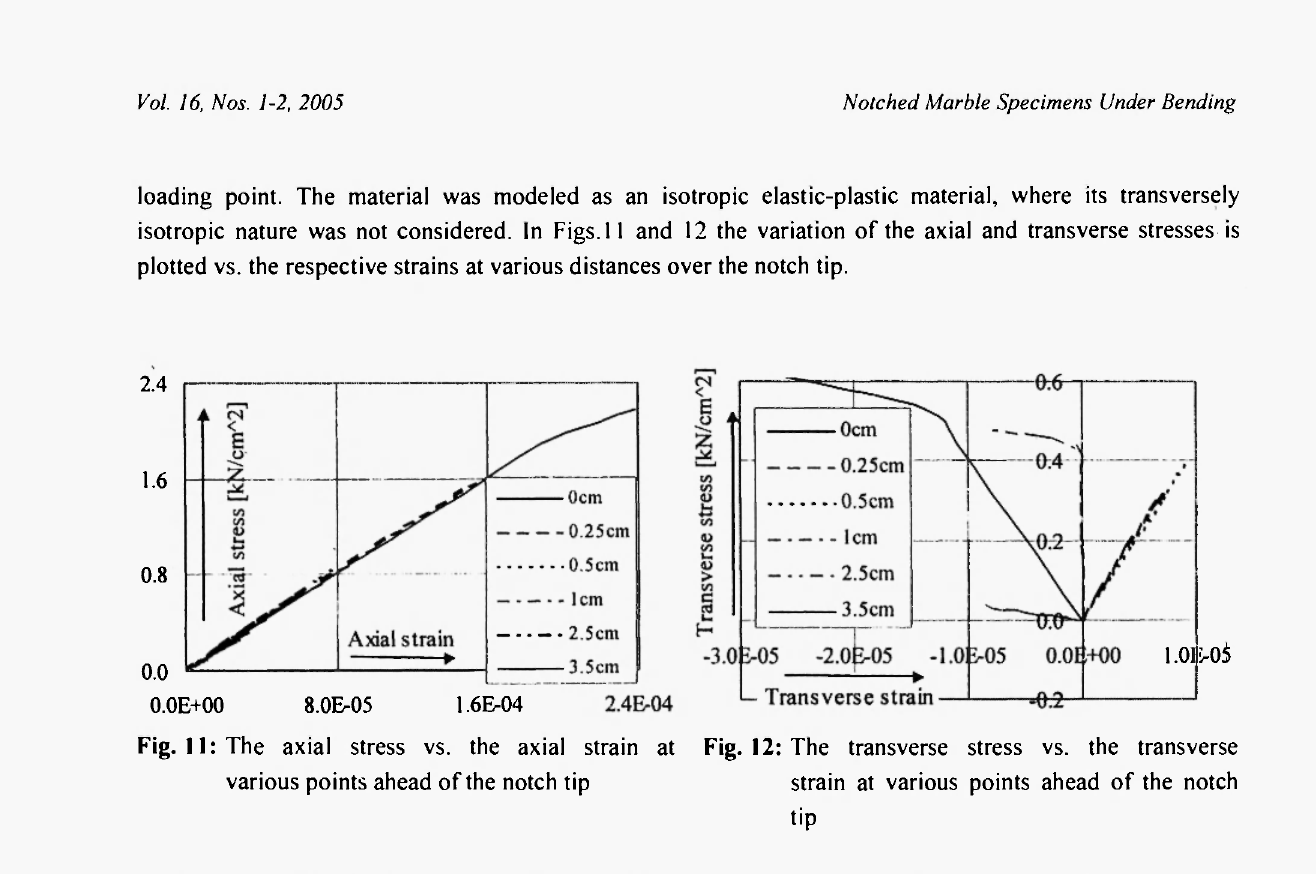
Fig. 11 : The axial stress vs. the axial strain at various points ahead of the notch tip